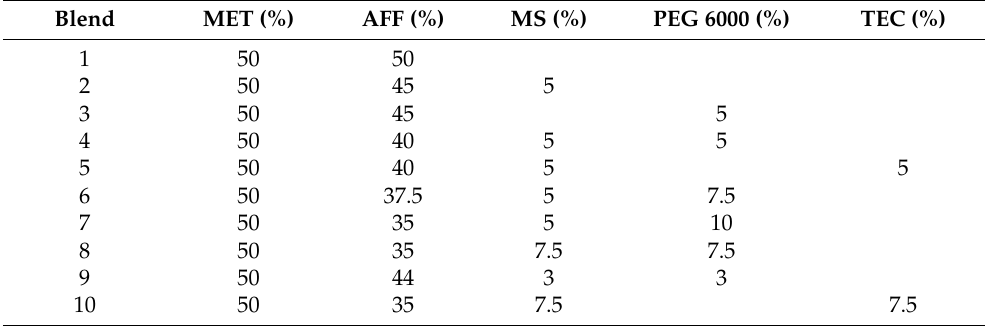
Table 1. Composition of preliminary blends to be extruded in filaments. All blends contained 50%